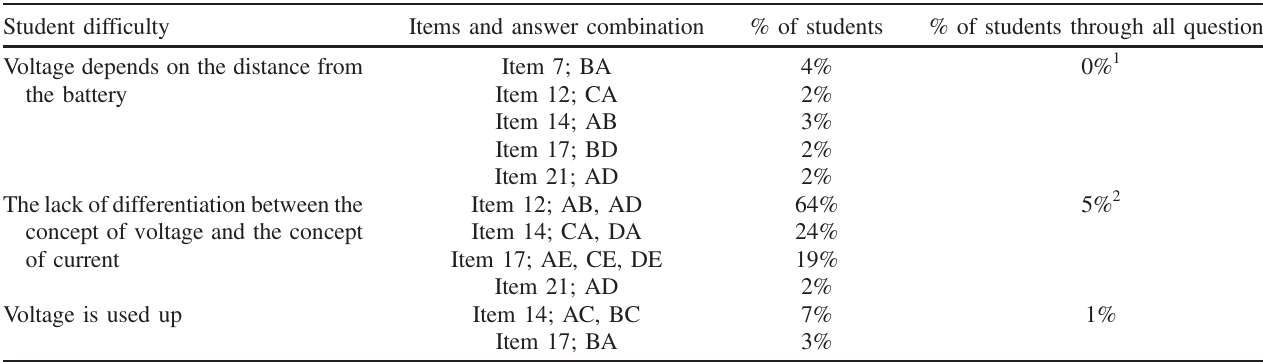
TABLE III. Three student difficulties with the concept of voltage and the items and answer combinations that help to detect